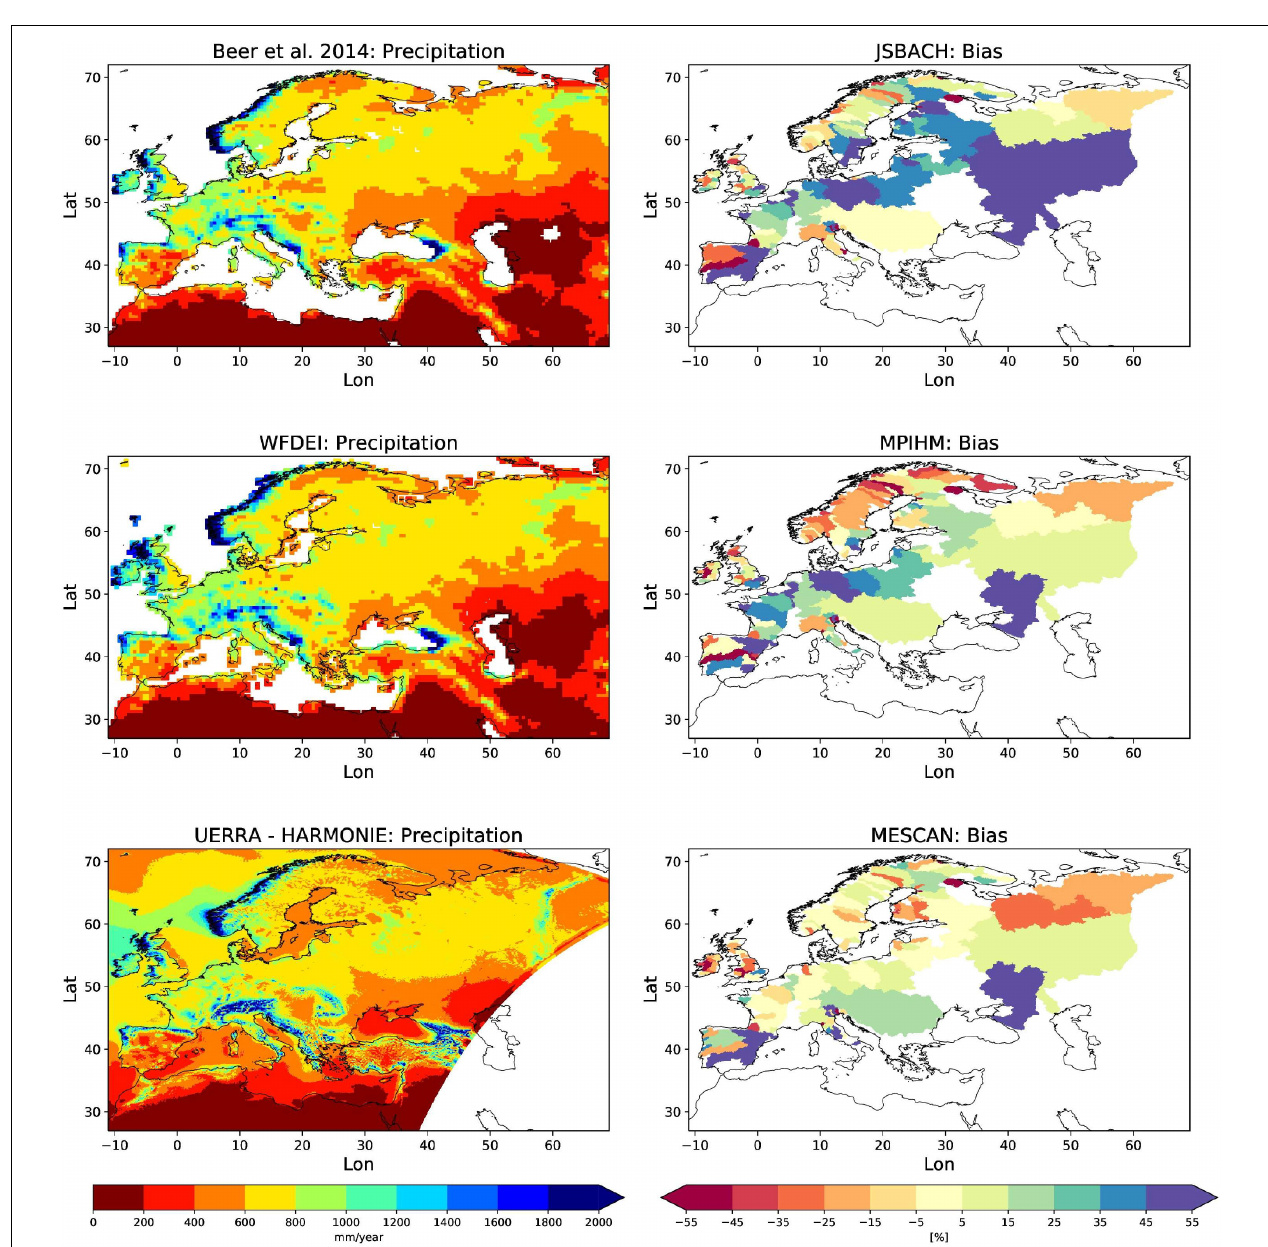
FIGURE 4 | Mean precipitation [mm/a] (left column) and bias in total runoff (right column) of the forcing data for Beer et al. (2014) and JSBACH (1st row), WFDEI and MPI-HM (2nd row), and UERRA-HARMONIE and MESCAN (3rd row), respectively.